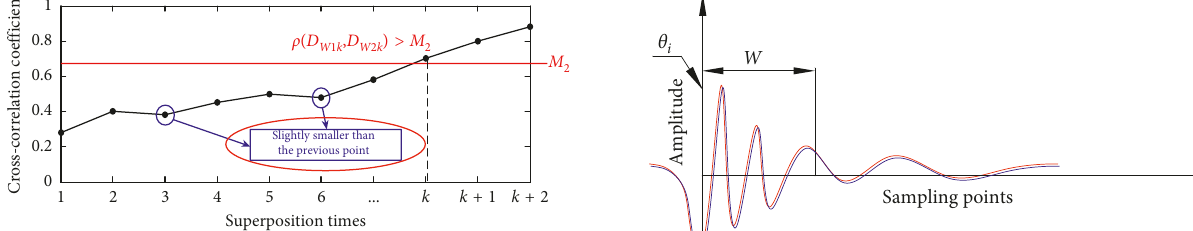
Figure 5: Relationship between fault features at different phases. If ρ ( D W 1 k , D W 2 k ) increases with the number of superpositions until it is greater than threshold M 2 , then the positional deviation can be ignored. ρ ( D W 1 k , D W 2 k ) is not strictly monotonous with the number of superpositions due to the influence of background noise, such as ρ ( D W 13 , D W 23 ) is less than ρ ( D W 12 , D W 22 ) and ρ ( D W 16 , D W 26 ) is less than ρ ( D W 15 , D W 25 ). Hence, ρ ( D W 1 k , D W 2 k ) is indirectly compared under the number of superpositions by using equation (4).